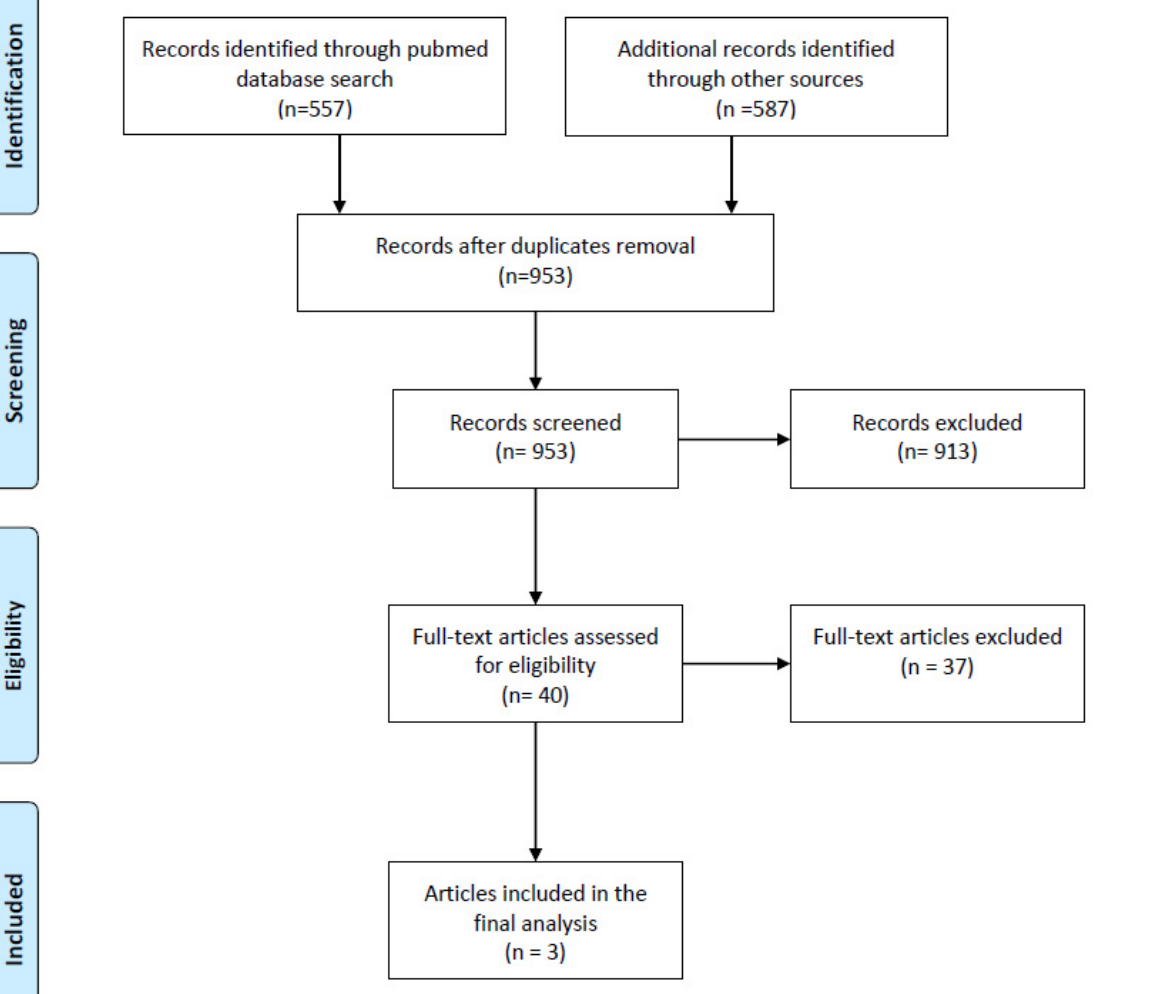
Figure 1. A flow chart of the systematic search process.